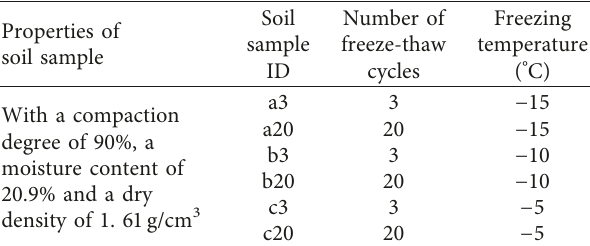
Table 4: Different schemes in the freeze-thaw cyclic